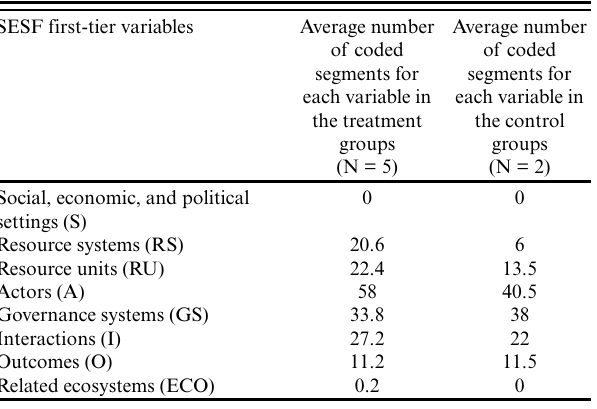
Table 3 . Each deliberation transcript from the treatment and control groups was coded for content in relation to the social- ecological system framework (SESF) second-tier variables. This table shows the mean number of coded segments from each group aggregated to each first-tier variable. The table allows comparison of the depth, i.e., amount of content within each first-tier, and complexity, i.e., the proportionality/evenness of content between first-tiers, of dialogue between the treatment and control